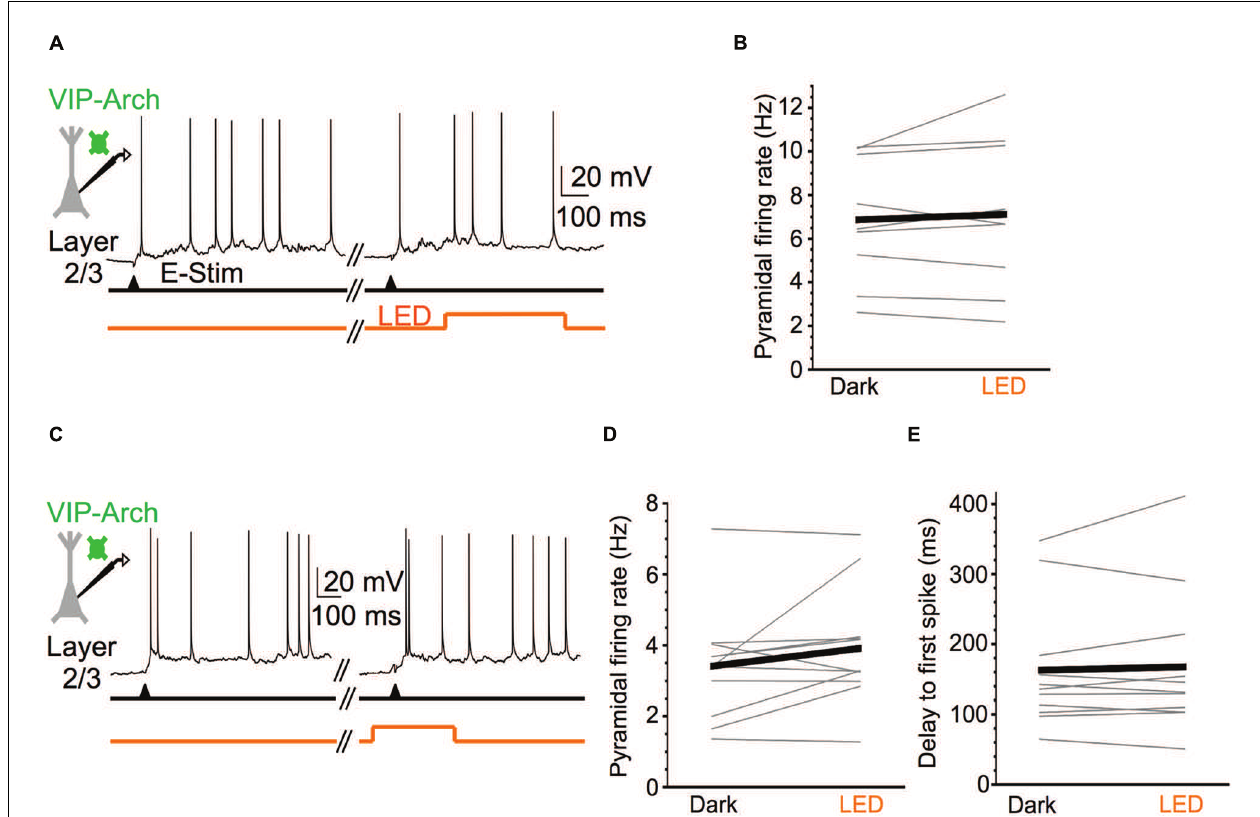
FIGURE 5 | Silencing VIP cells during Up states does not affect pyramidal cell excitability. (A) Representative Up state membrane potential trace of a layer 2/3 pyramidal cell with and without optogenetic stimulation of Arch-expressing VIP cells in layer 2/3. (B) Population data demonstrating layer 2/3 pyramidal cell Up state firing rates do not significantly change when VIP cells are silenced ( n = 9 cells; Dark: 6.9 ± 0.9 Hz, LED: 7.1 ± 1.2, P = 0.47, paired t -test). (C) As in (A) , but for a layer 2/3 pyramidal cell in which light stimuli were turned on before Up state onset and remained on for the first 250 ms of the Up state. (D) Population data demonstrating layer 2/3 pyramidal cell Up state firing rates do not significantly change when VIP cells are silenced during Up state onset ( n = 10 cells, different set of neurons than in B ; Dark: 3.4 ± 0.5 Hz, LED: 3.9 ± 0.5 Hz, P = 0.14, paired t -test). (E) As in (D) , but population data are delays from electrical stimulation to firing of the first action potential during an Up state ( n = 10 cells, same set of neurons as in D ; Dark: 163.0 ± 27.2 ms, LED: 167.6 ± 40.0 ms, P = 0.56, paired t